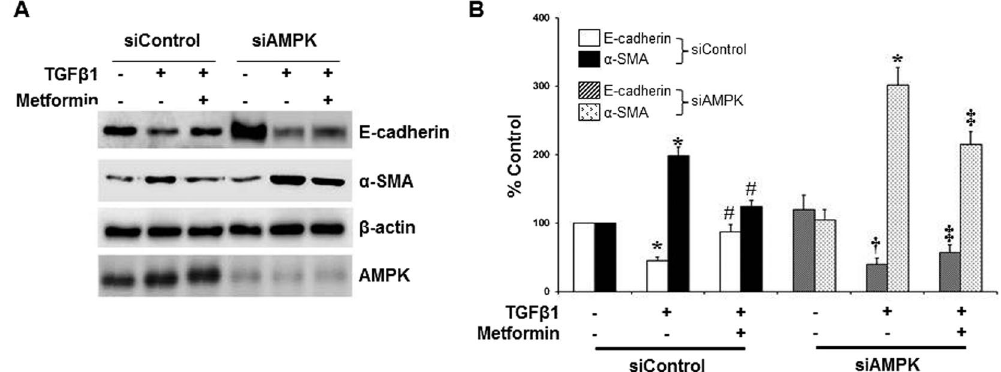
Figure 8. Effect of AMPK Gene Silencing on Amelioration of EMT by Metformin in HPMCs. AMPK gene silencing by siRNA does not affect the constitutional expression of E-cadherin and α -SMA. siAMPK alleviates the effect of metformin to block or ameliorate TGF- β 1-induced changes in the expression of E-cadherin and α -SMA in HPMCs. Representative western blots ( A ) with quantitative bars ( B ) at 24 hours of TGF- β are shown. (n = 4). * p < 0.05 vs. others at each siRNA condition, # p < 0.05 vs. TGF- β at siControl, † p < 0.05 vs. E-cadherin of control at siAMPK, ‡ p < 0.05 vs. E-cadherin or α -SMA of TGF- β+ metformin at